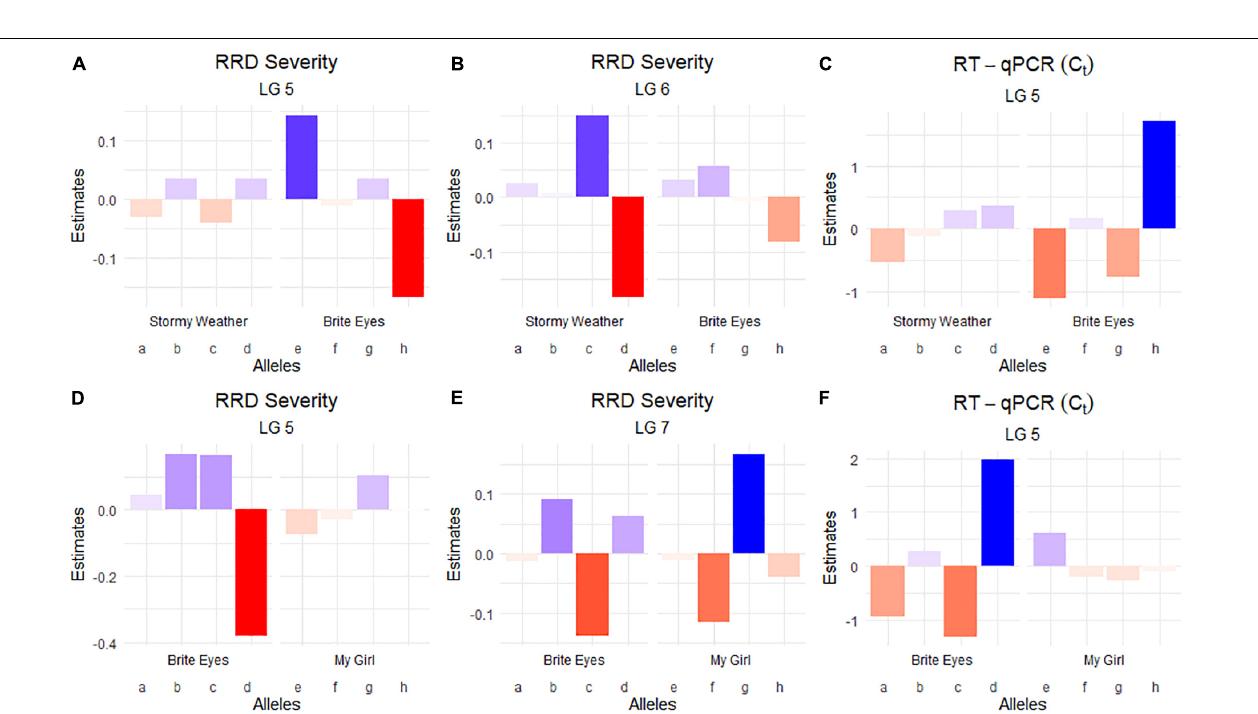
FIGURE 4 | Quantitative trait locus allele effect estimates from QTLpoly on rose rosette disease severity and Rose rosette emaravirus RT-qPCR from two biparental tetraploid garden rose mapping populations. Bar plots indicate the direction of the QTL’s effect. (A–C) Allele effect plots of RRD severity for QTL on LGs 5 and 6, and for the RRV detection measured using RT-qPCR on LG 5 in the SWxBE population. (D–F) Allele effect plots of RRD severity for QTL on LGs 5 and 7, and for the RRV detection measured using RT-qPCR on LG 5 in the BExMG population.